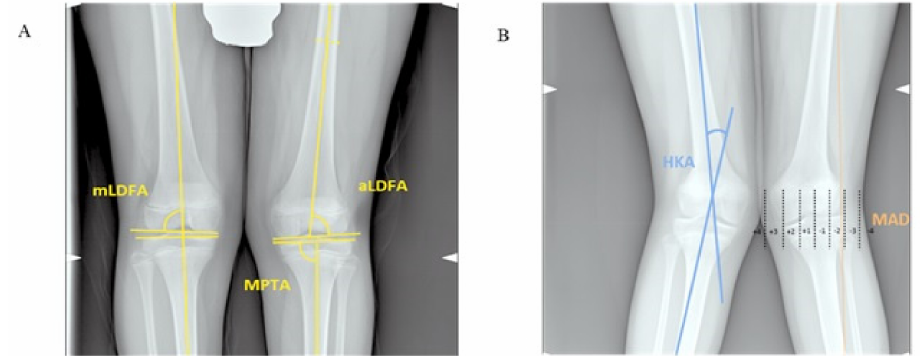
Figure 2. Long-standing anteroposterior radiographs of the lower extremities illustrating the method for determining the ( A ) mechanical lateral distal femoral angle (mLDFA), anatomical lateral distal femoral angle (aLDFA), medial proximal tibial angle (MPTA), ( B ) hip–knee–ankle angle (HKA), and mechanical axis deviation (MAD) in genu valgum. ( A ) The mLDFA and aLDFA are the lateral angle formed between the lines of the mechanical and anatomical femoral axes, respectively, and the articular surface of the distal femur. The MPTA is the medial angle formed between the line of the mechanical tibial axis (that corresponds to the anatomical tibial axis) and a line tangent to the joint surface of the proximal tibial plateau. The HKA is the angle between a line drawn from the center of the femoral head to the center of the knee joint and a line drawn from the center of the knee joint to the center of the tibial plafond. Positive values for varus knee, negative values for valgus knee. The MAD is the perpendicular distance from the mechanical axis of the lower extremity line to the center of the knee joint. MAD zones were labelled from 1 to 4, corresponding to the severity of the deformity. Positive values were assigned for valgus and negative values for varus deviations. Deviations were expressed as a percentage to one-half of the width of the tibial plateau, and the knee joint was divided into four quadrants (two negative and two positive). By definition, deviation between 0% and 50% falls into zone 1, 51% to 100% into zone 2, 101% to 200% into zone 3, and >200% into zone